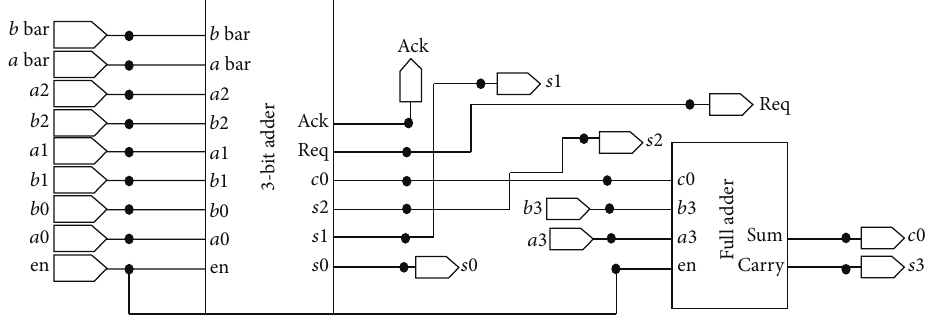
Figure 6: Design of full adder.